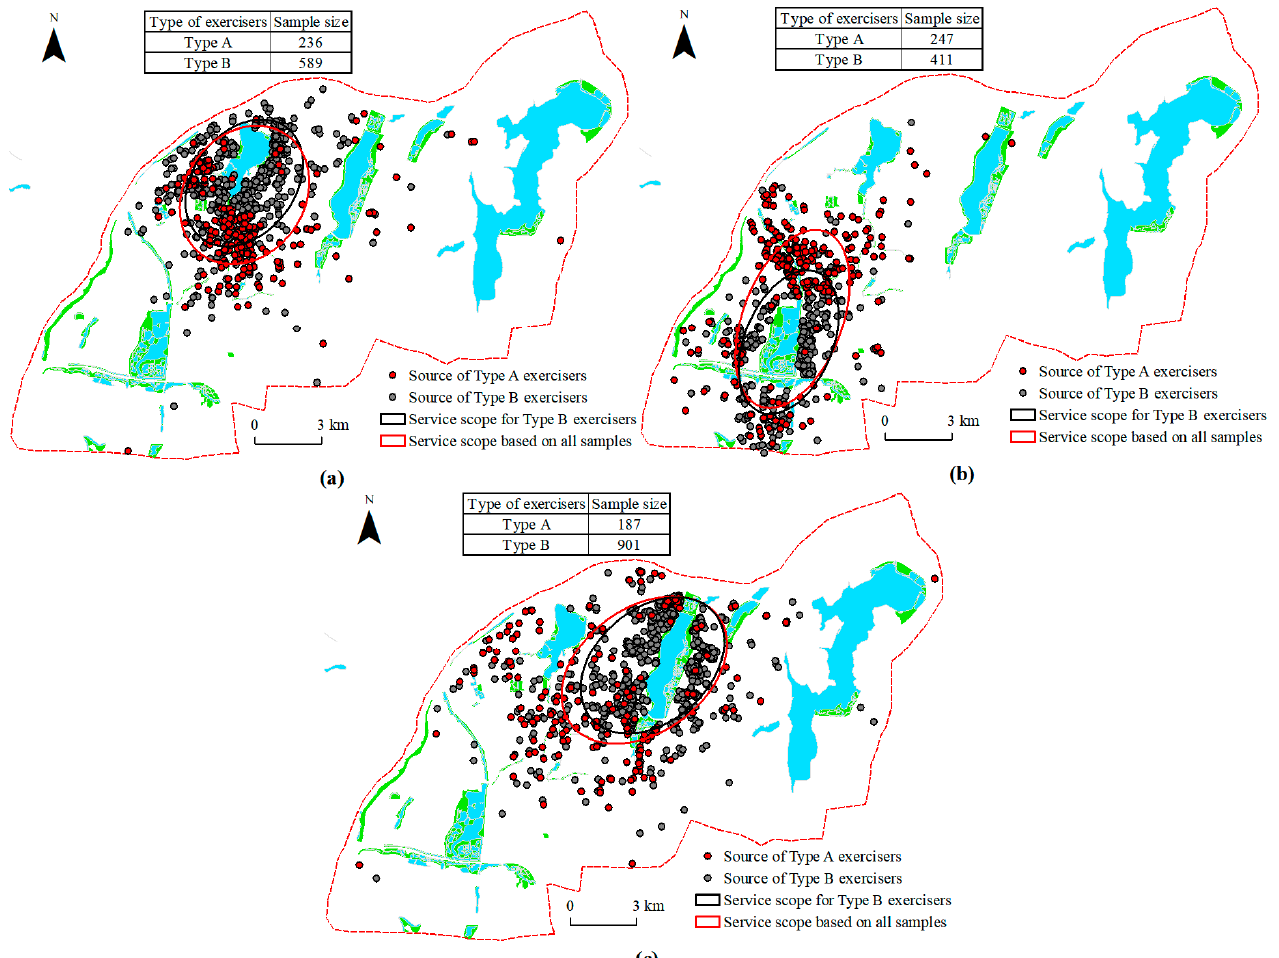
Figure 9. Source and distribution of different types of exercisers in the first-level patches: ( a ) Qingshan Scenic Spot; ( b ) Xianghu Park; and ( c ) Aisihu Park.